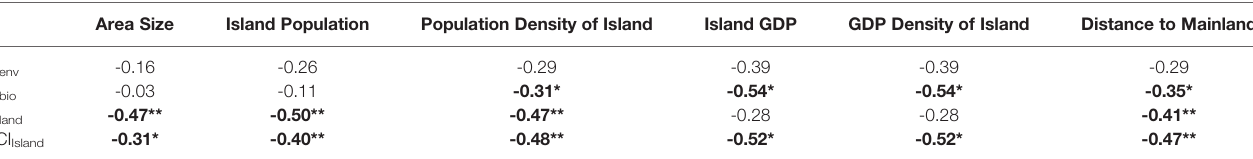
TABLE 8 | Pearson correlation coef fi cients between island condition indices and geographical-social-economic